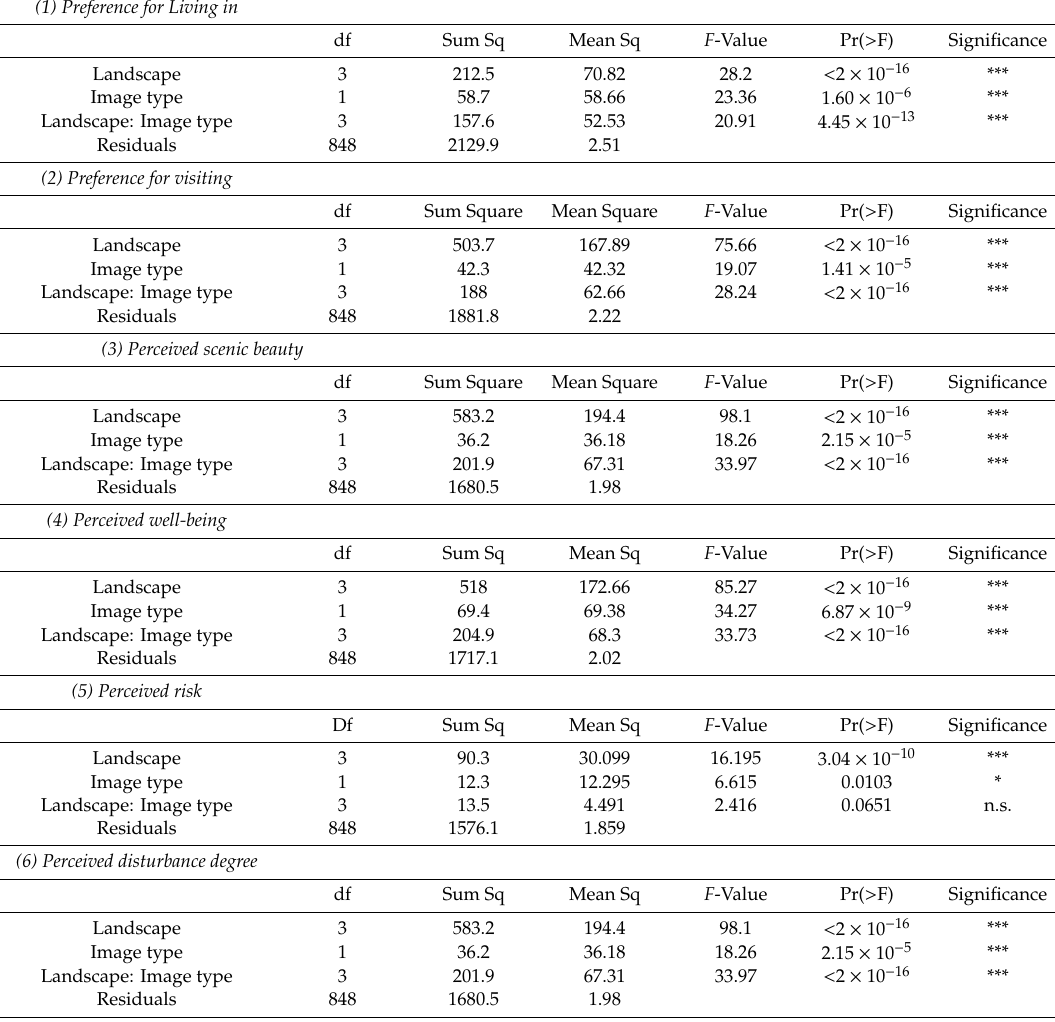
Table A2. ANOVAs for six questions on preference values for four landscapes using two image types (eye-level and aerial). For results on Tukey’s post hoc comparisons for the interaction terms, see Figure 4 in the main text. ***: p < 0.001, **: p < 0.01, *: p < 0.05, n.s.: no